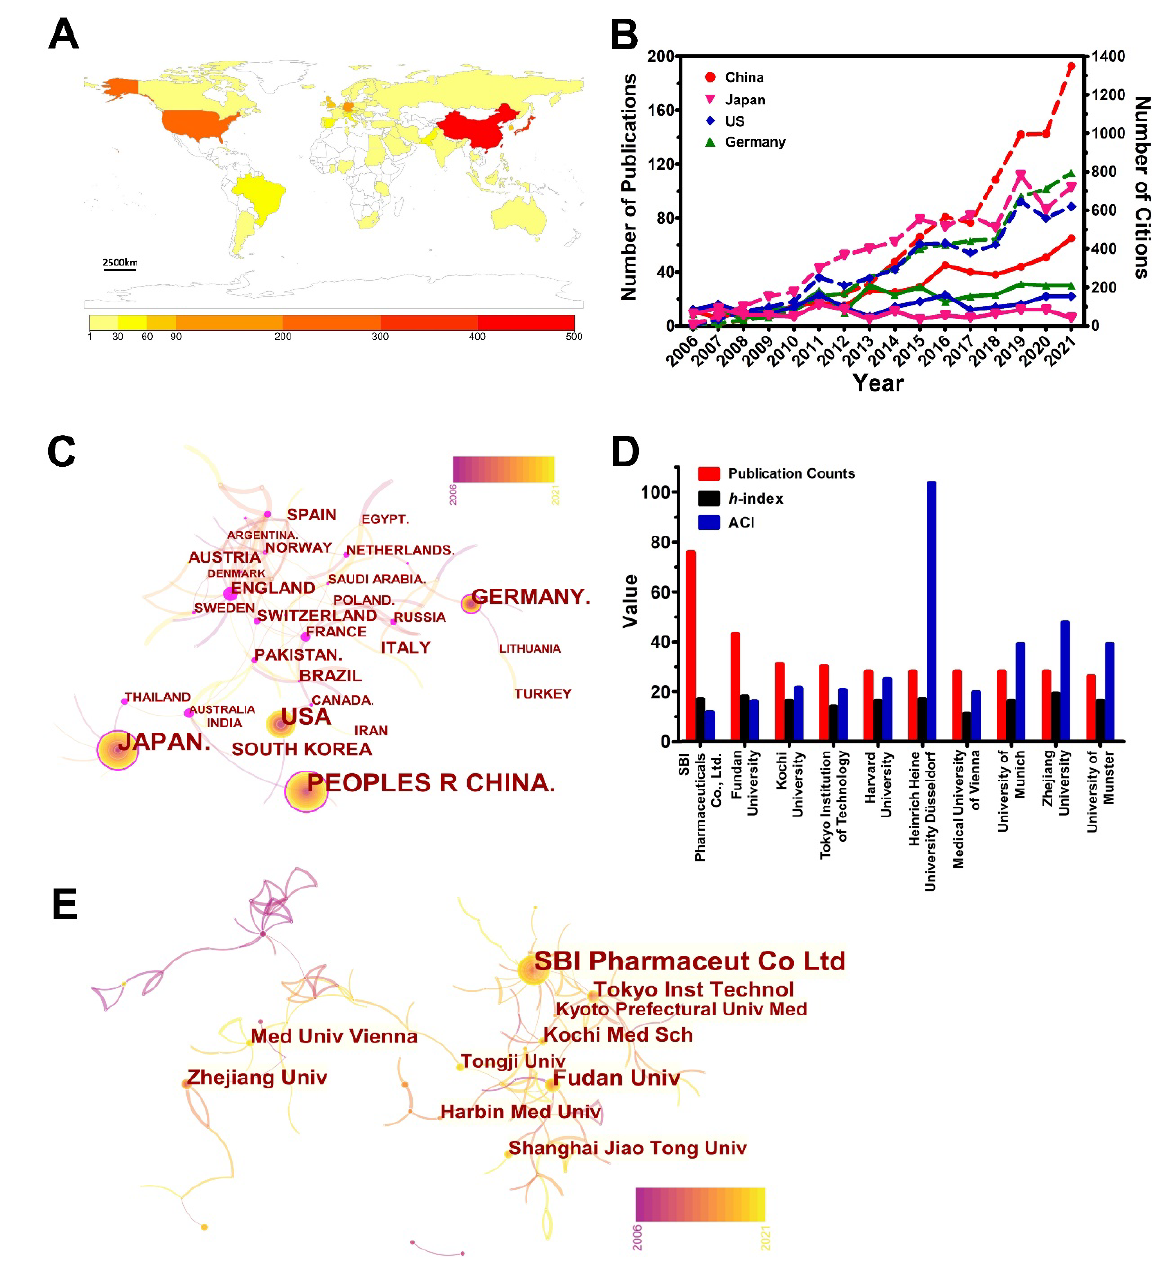
Figure 2. Contributions of different countries and institutions. ( A ) The exhibition of countries in the geographical map with publication counts. ( B ) The evolution trends of publications and citations of four major countries. Solid line indicates publications and dotted line indicates citations. ( C ) Co-occurrence network of countries analyzed by CiteSpace. ( D ) The graph of publication number, h -index, and ACI of the top-10 most active institutions. ( E ) Cooperation network of institutions analyzed by CiteSpace.